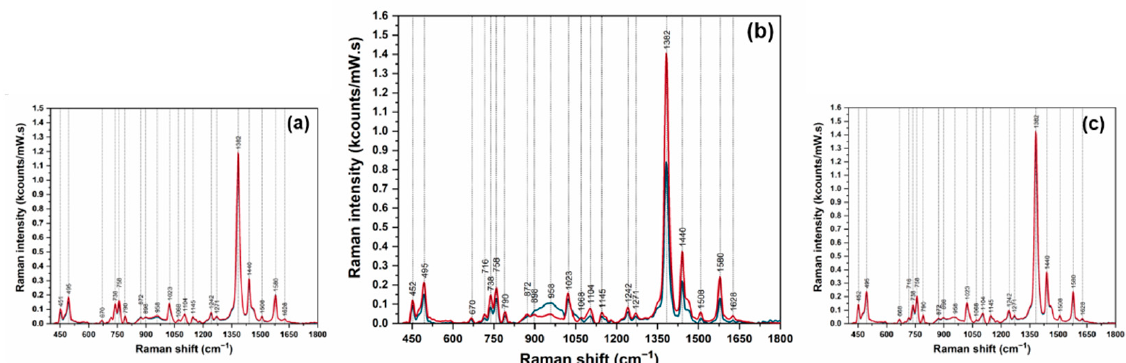
Figure 4. SER spectra of the host–guest complexes formed between R/S-PRNL and α CDs ( a ), β CDs, ( b ) and γ CDs ( c ). The complexes formed with R-PRNL and S-PRNL are plotted in blue and red, respectively.